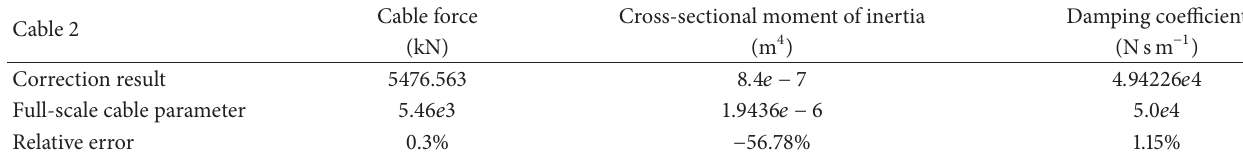
Table 5: Model updating results for simulated cable B11.